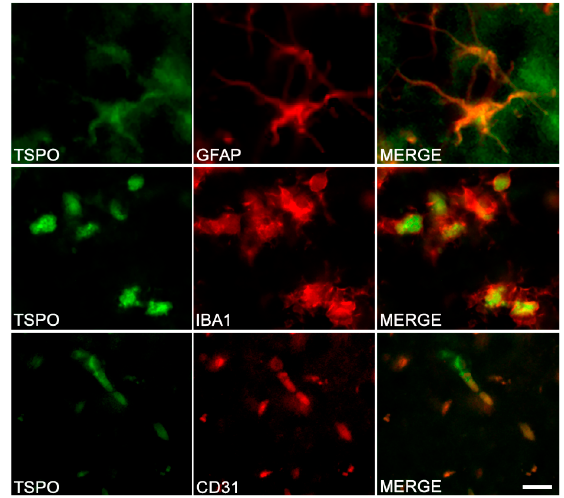
Figure 4. TSPO in different cell types of the hippocampus in TgF344-AD rats. Double-immunostaining was performed to detect TSPO (left column) and specific marker of astrocytes (GFAP), microglia (IBA1) and endothelial cells (CD31). Merge images demonstrate the colocalization of TSPO with astrocytes, microglia and endothelial cells. Scale bar: 10 µ m. Adapted from Reference [122].